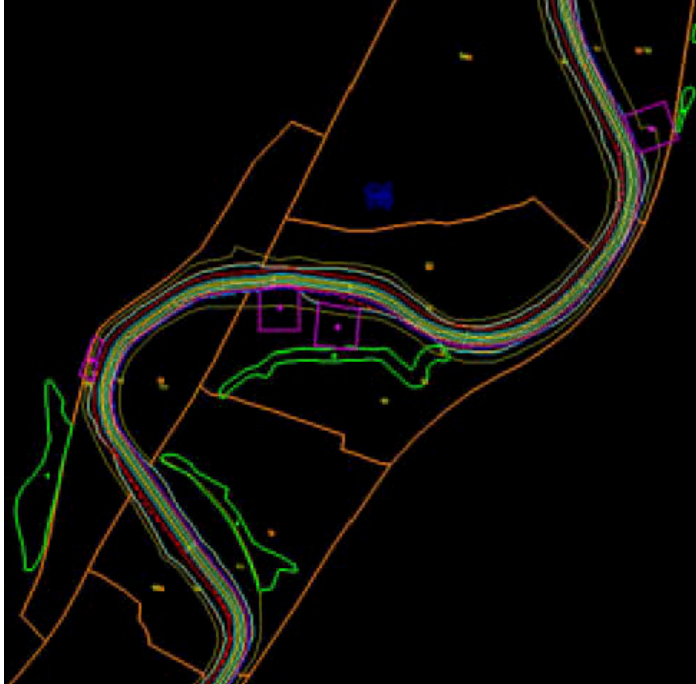
FIGURE 4: The GIS example; the areas of the river corridor analysed by the ELI are brown; the areas of botanical interest are green; the IA of the banks analysed by the BSI and WSI are yellow magenta. The river classes for the monitoring of the water quality according to Italian law: ecological state, macrodescriptors level, biological quality, drinkable use, bathing, Salmonid and Cyprinid suitability, irrigation[10, modified;